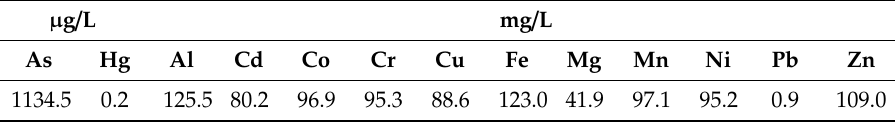
Table 1. Elements detected by ICP-OES in fly ash aqueous